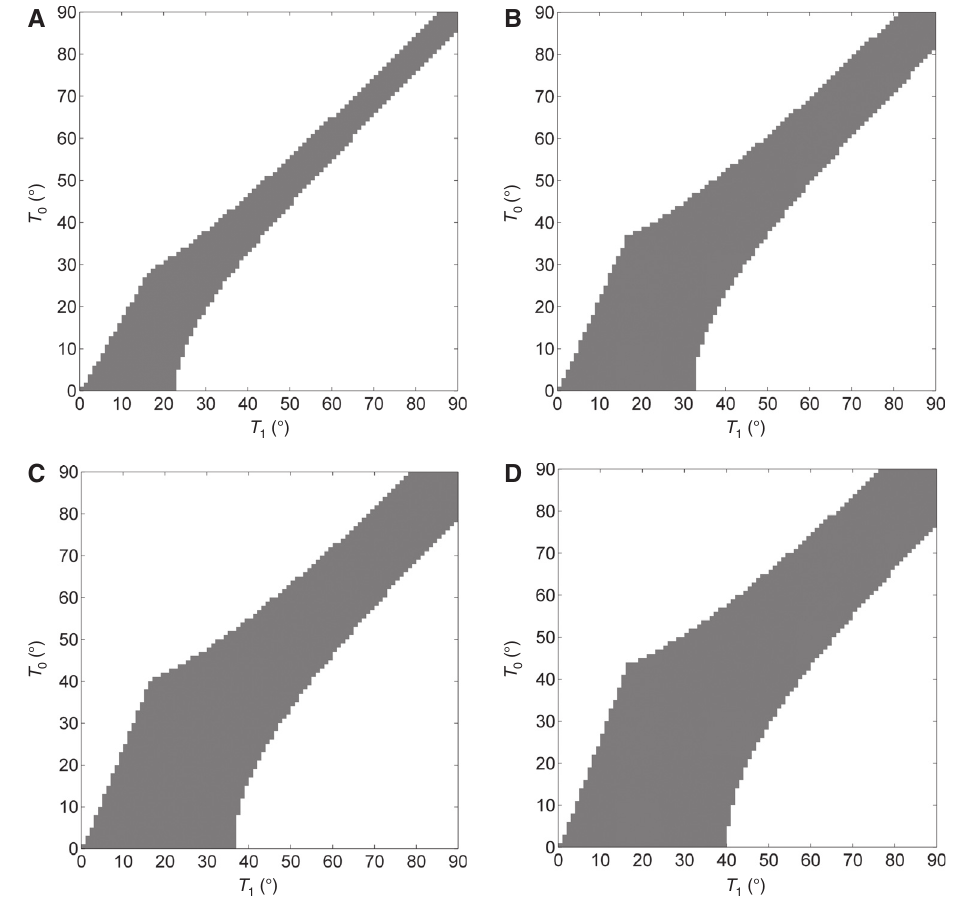
Figure 2 Feasible design space (shaded area) for different plate sizes. (A) 0.101 × 0.152 m, (B) 0.203 × 0.303 m, (C) 0.254 × 0.406 m, (D) 0.303 ×